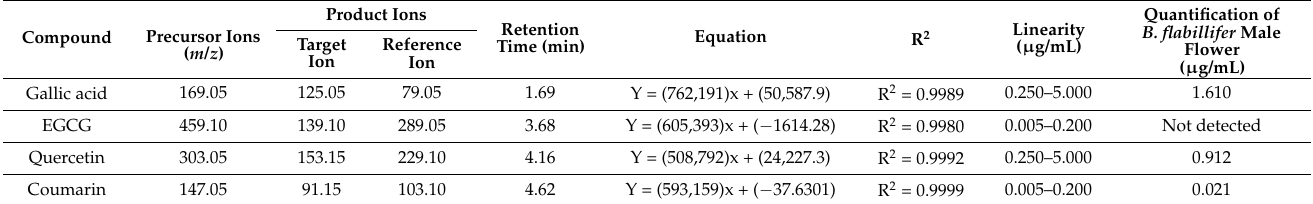
Table 1. Identification and quantification of compounds of ethanol extract of B. flabellifer male flower by LC–MS/MS.